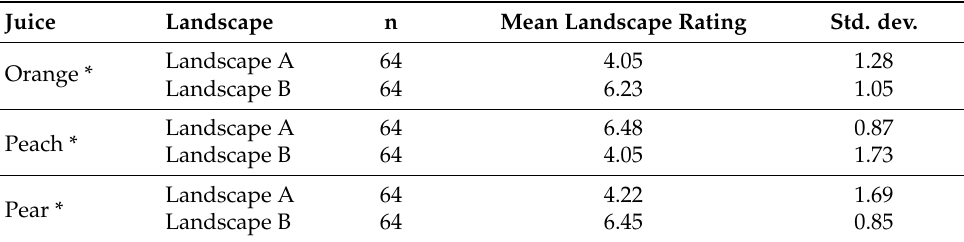
Table A2. Mean landscape rating about the aesthetic quality of the images representing the production area of the fruit used to prepare the juices.